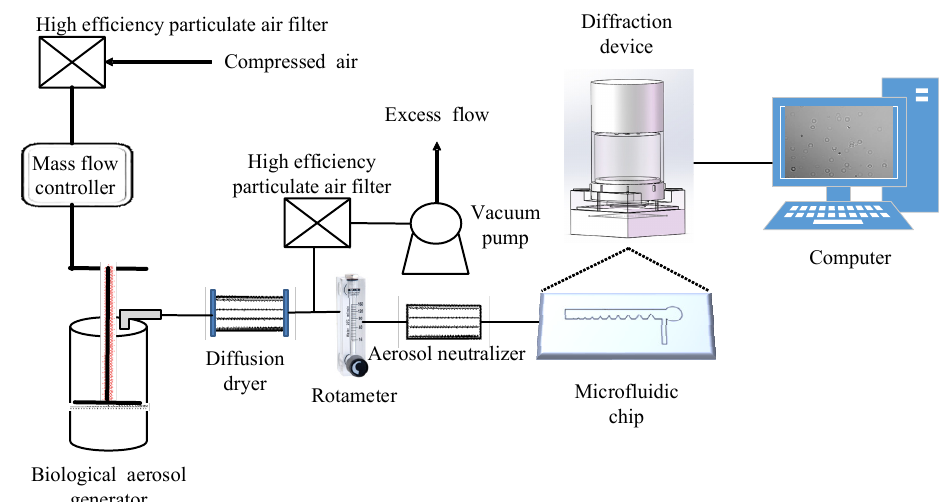
Figure 7. Schematic diagram of the experimental platform. Figure 8 is an experimental image taken by the inverted microscope. As can be seen